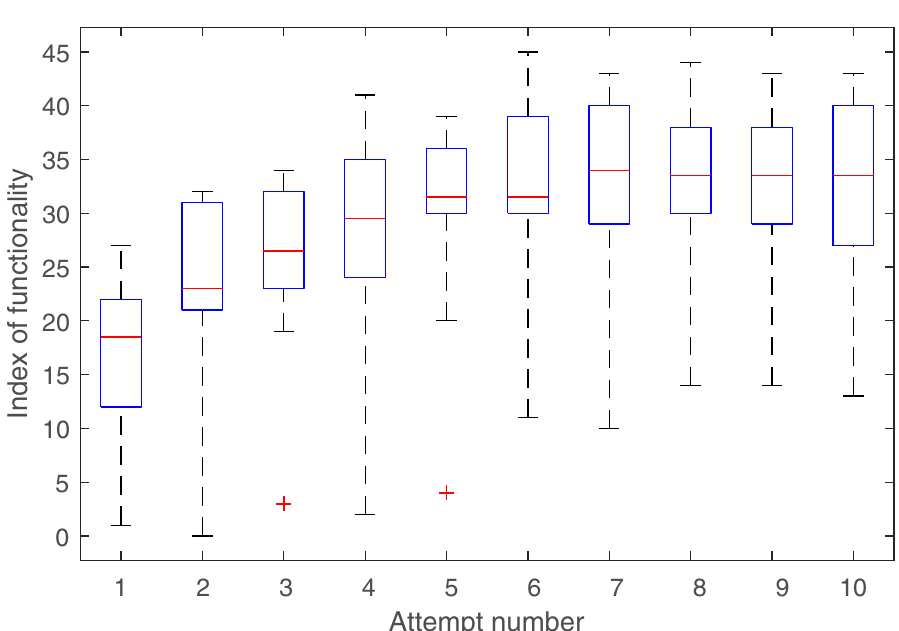
Fig 3. Box plot of SHAP IoF scores across all 10 participants. Outliers were labelled according to 2.2 � IQR [18]. Participant 7 performed the tasks slower than the other participants explaining the long whiskers for the lower bound, however the improvement trend was the same, and there were no outliers when looking at the differences in SHAP score between attempts.